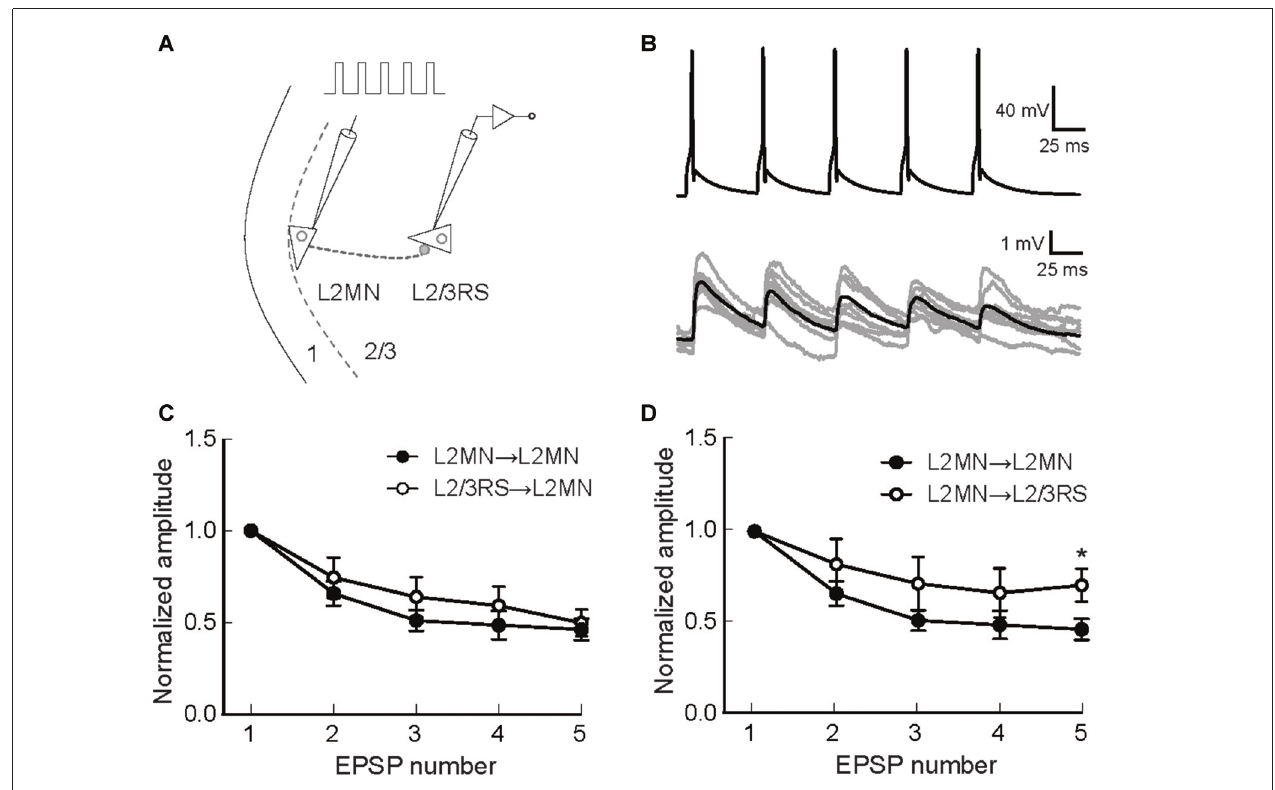
FIGURE 7 | Short-term synaptic dynamics of synapses formed by L2MNs and synapses formed on L2MNs. (A) A schematic drawing of the stimulation and recording methods. Five current pulses were injected into the presynaptic neuron to evoke APs at approximately 20 Hz. (B) An example of recordings from a L2MN → L2MN pair. The upper panel shows APs evoked in the presynaptic neuron and lower panel shows EPSPs evoked by the presynaptic APs in the postsynaptic neuron. Gray traces are from eight consecutive recordings and the black trace is the average of 16 recordings including the eight gray traces. (C) Short-term dynamics of synapses formed onto L2MNs. EPSP amplitude was normalized to that of the first one. Depression was found for both L2MN → L2MN synapses and L2/3RS → L2MN synapses. No significant difference was found in the extent of depression. (D) Short-term dynamics of synapses formed by L2MNs. Stronger depression was found for the 5th EPSP when a L2MN neuron was the postsynaptic neuron, compared to the case where a L2/3RS neuron was the postsynaptic neuron. Error bar = SEM; ∗ p <